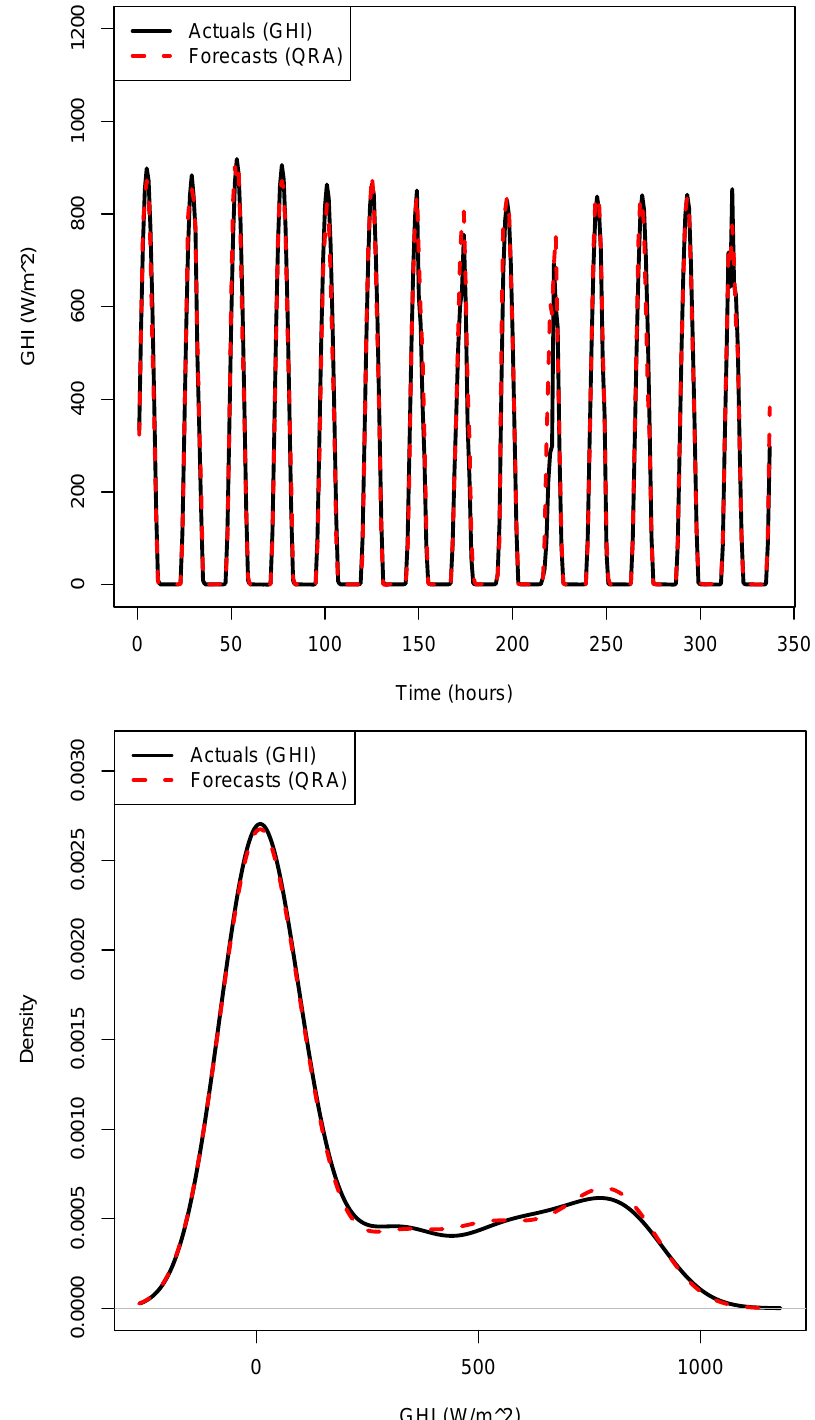
Figure 7. Top panel: Actual and predicted GHI in April 2010 (337 forecasts). Bottom panel: Actual and predicted density plots of